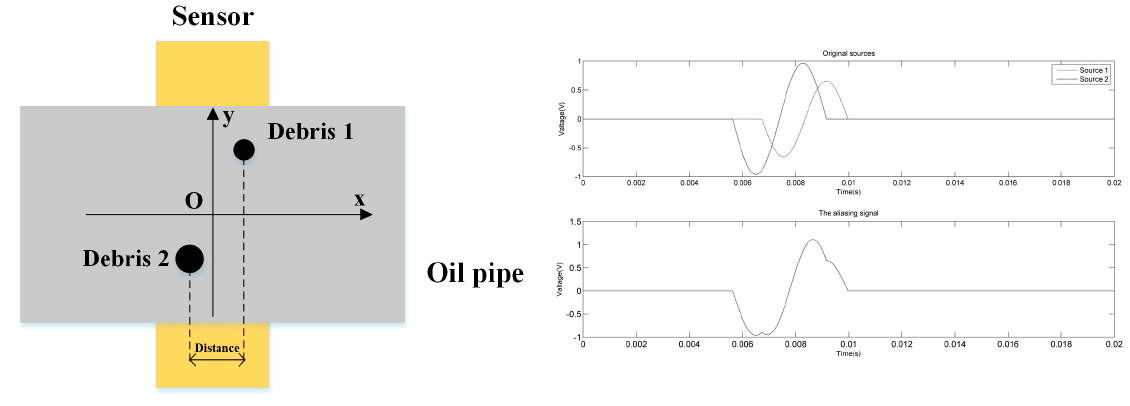
Figure 1. The aliasing phenomenon.